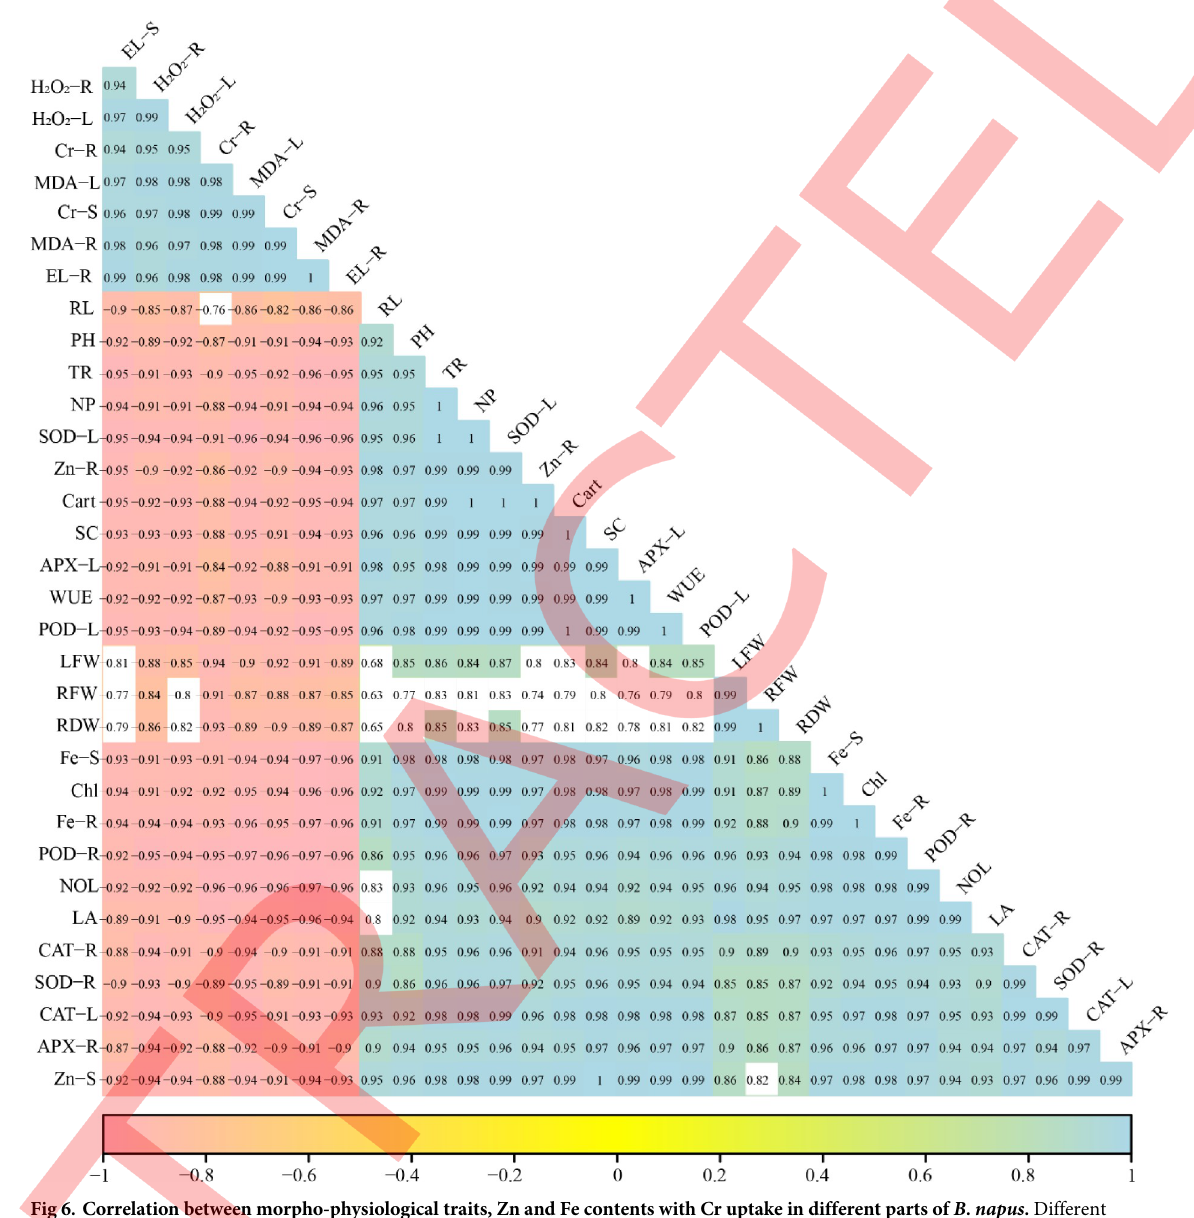
Fig 6. Correlation between morpho-physiological traits, Zn and Fe contents with Cr uptake in different parts of B . napus . Different abbreviations used in this figure are as follow: H 2 O 2 -R (H 2 O 2 initiation in roots), H 2 O 2 -L (H 2 O 2 initiation in leaves), CR-R (Cr contents in roots), MDA-L (MDA contents in leaves), CR-S (Cr contents in leaves), MDA-R (MDA contents in roots), EL-R (electrolyte leakage in roots), RL (root length), PH (plant height), TR (transpiration rate), NP (net photosynthesis), SOD-L (SOD activity in leaves), Zn-R (Zn contents in roots), Carot (carotenoid contents), SC (stomatal conductance), APX-L (APX activity in leaves), WUE (water use efficiency), POD-L (POD activity in leaves), LFW (leaves fresh weight), RFW (root fresh weight), RDW (root dry weight), Fe-S (Fe contents in shoots), Chl (total chlorophyll contents), Fe-R (Fe contents in roots), POD-R (POD activity in roots), NOL (number of leaves), LA (leaf area), CAT-R (CAT activity in roots), SOD-R (SOD activity in roots), CAT-L (CAT activity in leaves) APX-R (APX activity in roots) and Zn-S (Zn contents in